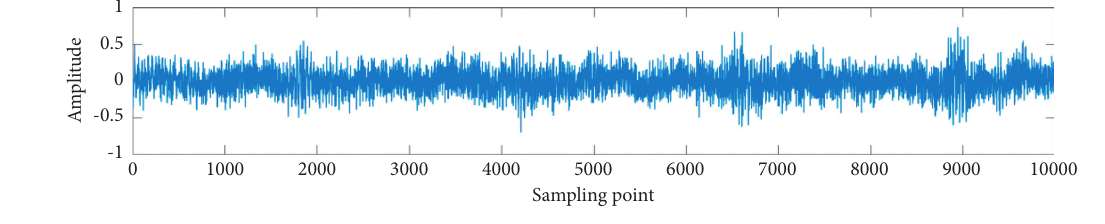
Figure 14: The physical map of the first cylinder lacking of the car engine. (1) Automotive engine; (2) the first cylinder line.